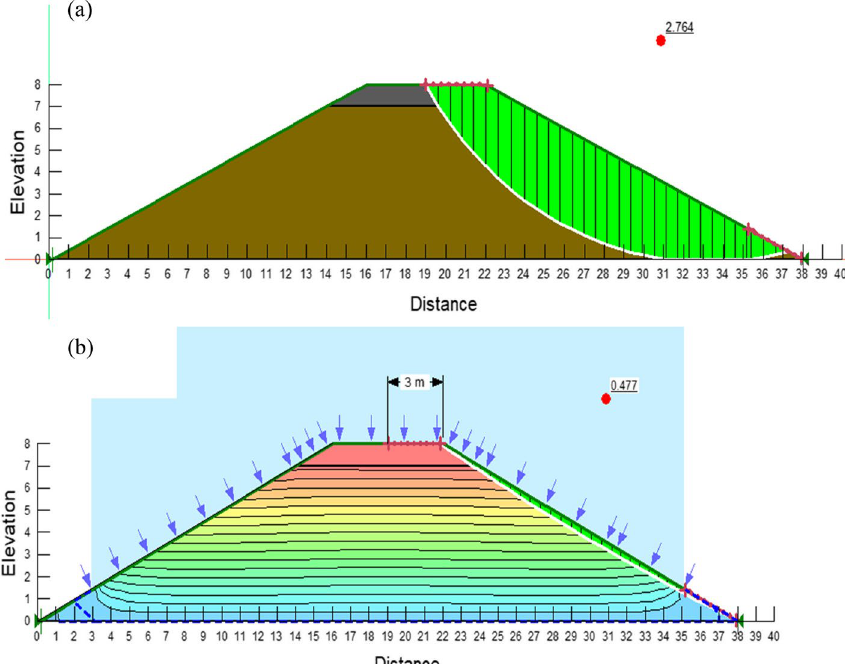
Fig. 21 a FOS of embankment without rainfall. b FOS at RG1 with maximum